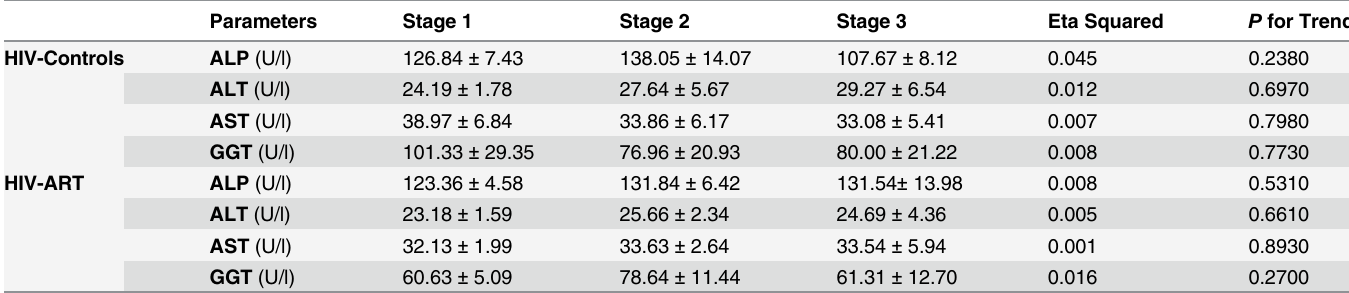
Table 7. Relationship between disease progression and ART-related hepatic